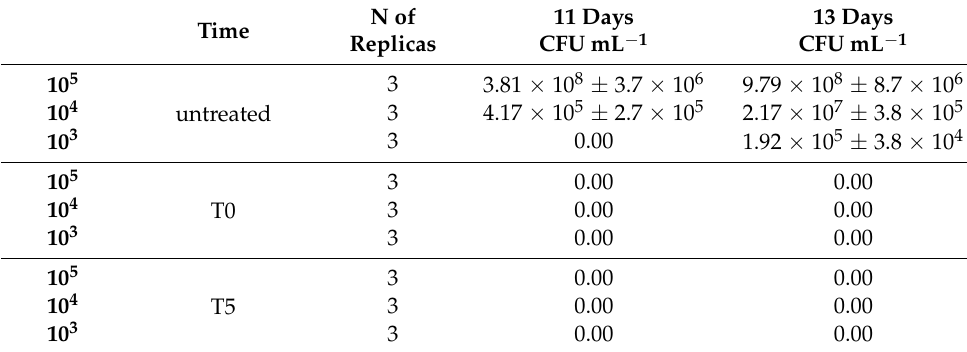
Table 1. Results of the experiment performed on agar surface grown XfDD. Treatment time was fixed at 200 s following the finding of the previous experiment. We performed experiments in triplicate for a total of 9 dishes each experiment. The experiments were conducted on plates just at T0 = 0 and T5 = 5 days after XfDD seeding.